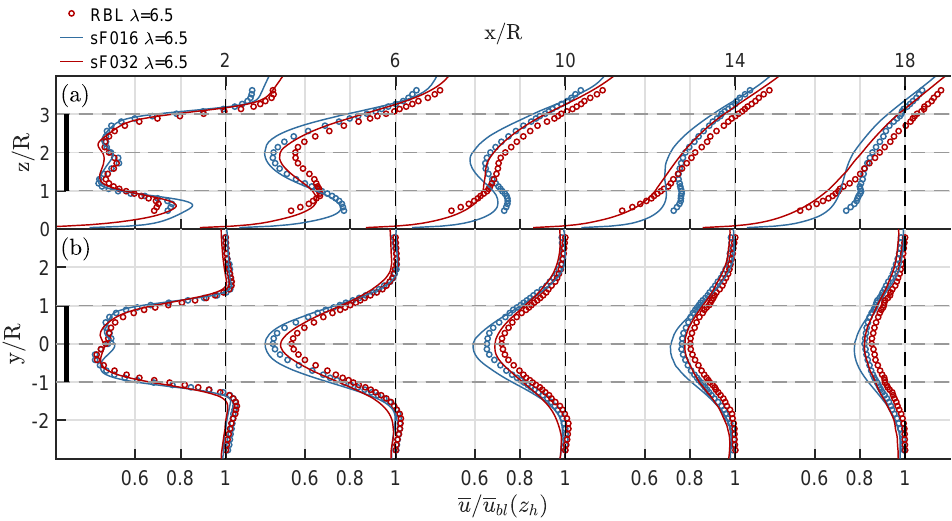
Figure 11. Profiles of the normalized mean axial velocity component u / u bl ( z h ) in the ( a ) mid − vertical and ( b ) mid − horizontal plane at axial positions x / R = 2, 6, 10, 14, 18. Symbols denote measurements, whereas lines correspond to LES results. The legend denotes the case. The origin of local coordinates in the upper subfigure is located at x = 0.8 and in the lower subfigure at x =